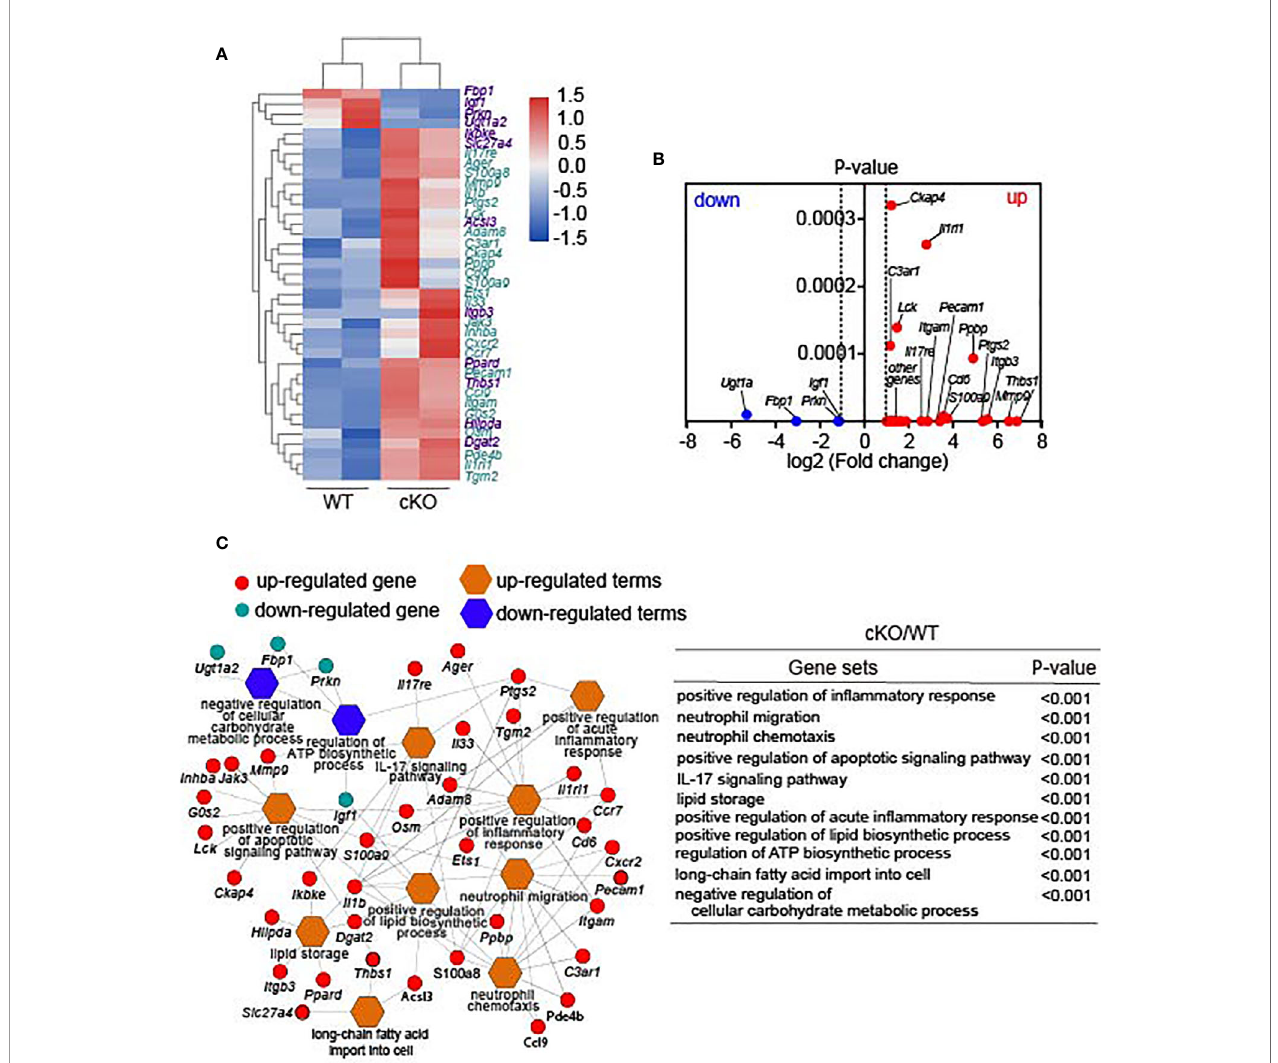
FIGURE 5 | Lkb1 regulates critical immune and metabolic gene expression in AMs. (A) Heat map showing differentially expressed genes between AMs from Lkb1 f/f and Cd11c Cre Lkb1 f/f mice; genes labeled purple are related to metabolism, and genes labeled blue are related to immune function. (B) Volcano plot showing differentially expressed genes in Lkb1-de fi cient AMs compared to AMs from Lkb1 f/f mice. (C) Network displaying the related genes involved in the pathways enriched in Lkb1-de fi cient AMs. The list (right) of gene sets and corresponding P -values are shown. CD45 + CD11c + SiglecF + AMs were sorted from the lungs of at least fi ve to 10 mice in each sample with a FACSAria III (BD Biosciences). A P -value < 0.05 was considered statistically signi fi